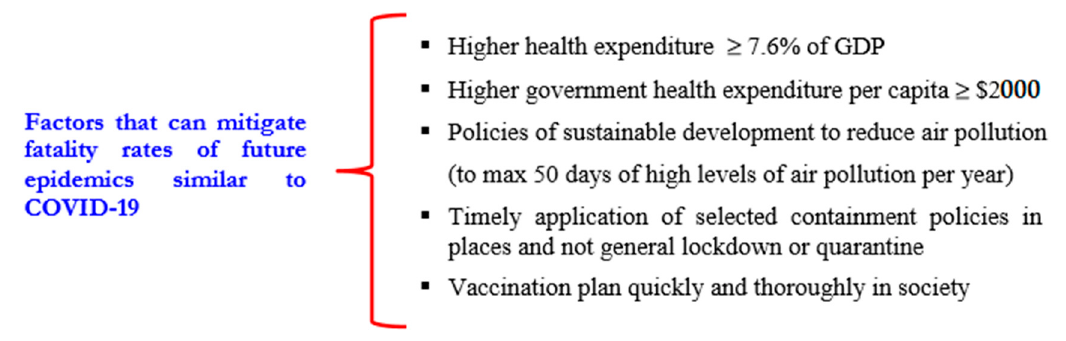
Figure 2. Factors associated with strategies to prevent negative effects of pandemic threats. Source : author’s own figure.